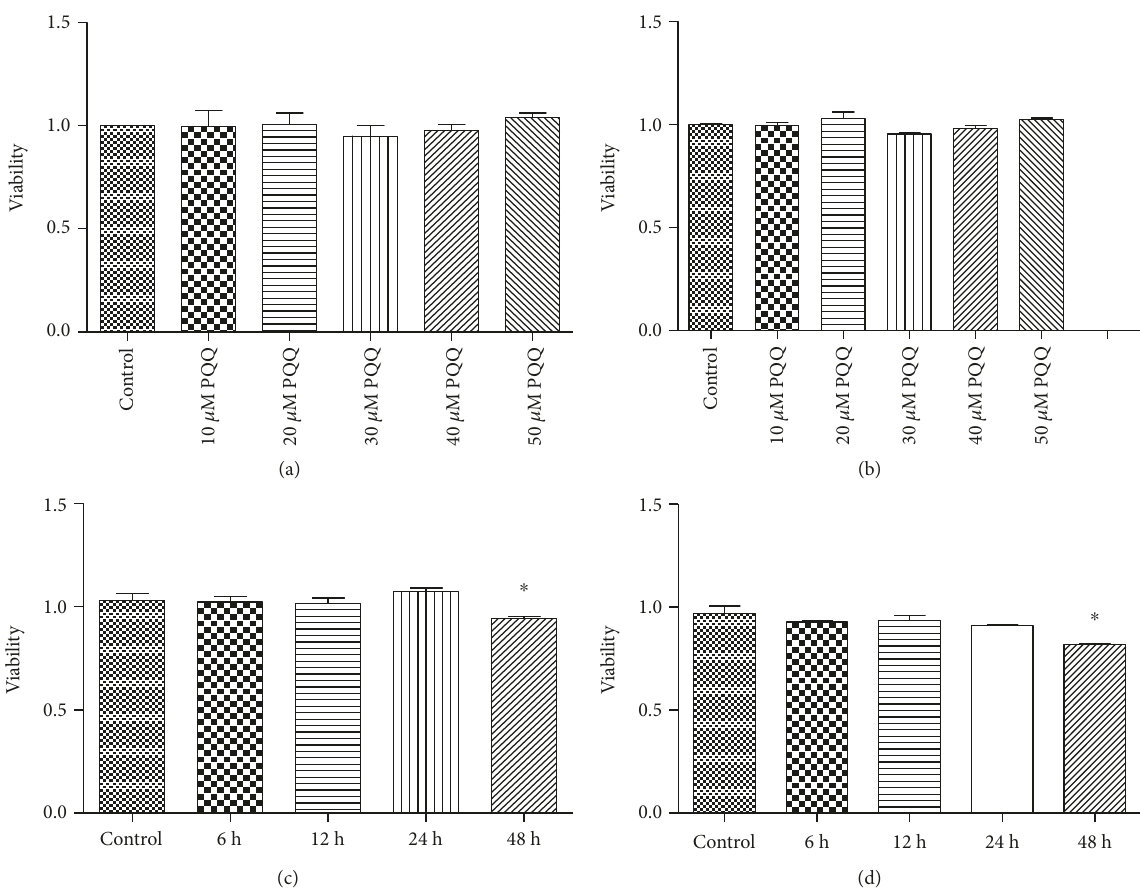
Figure 12: The e ff ect of PQQ on the viability of PC12 and SHSY5Y cells. (a) Control: PC12 cells without PQQ; (b) control: SHSY5Y cells without PQQ; (c) control: PC12 cells without PQQ, ∗ P < 0 05 versus control; (d) control: SHSY5Y cells without PQQ, ∗ P < 0 05 versus